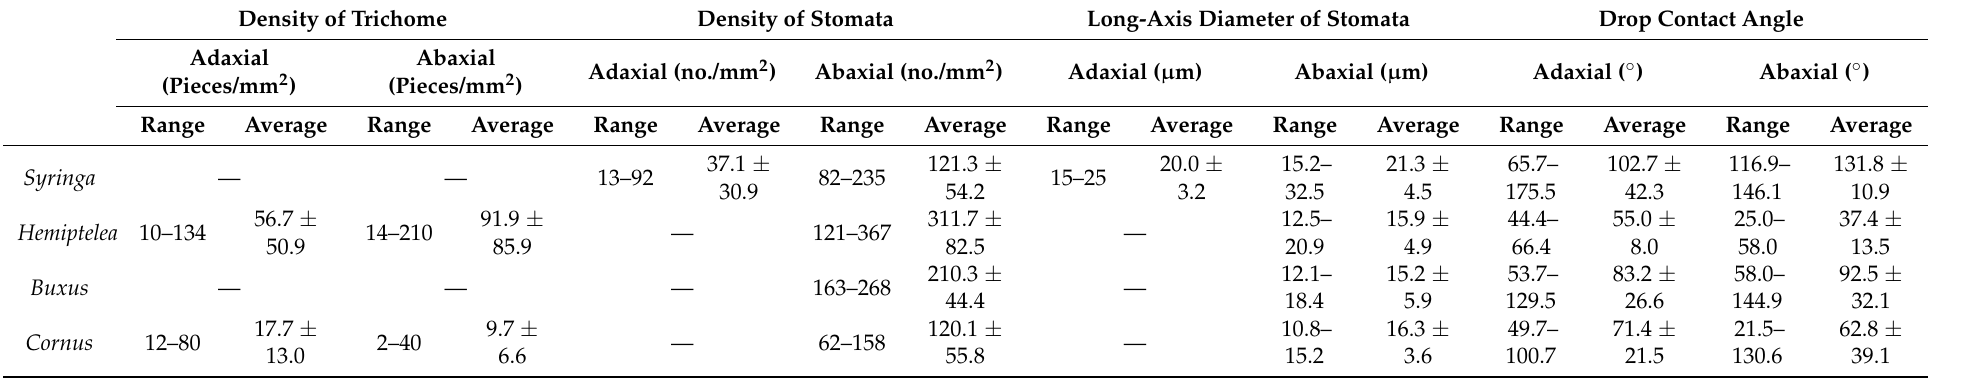
Table 2. Leaf microstructural traits of different